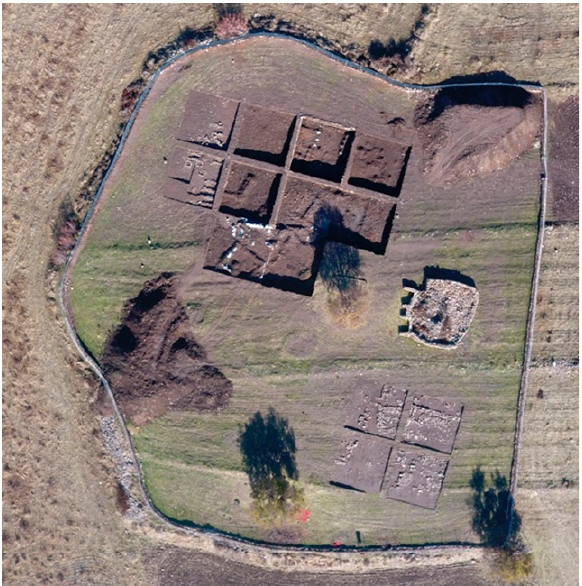
Figure 2. The aerial photography of the trenches at Kendale Hecala (excavation archive). Table 1. The cultural sequences at Kendale Hecala. Date (BC)